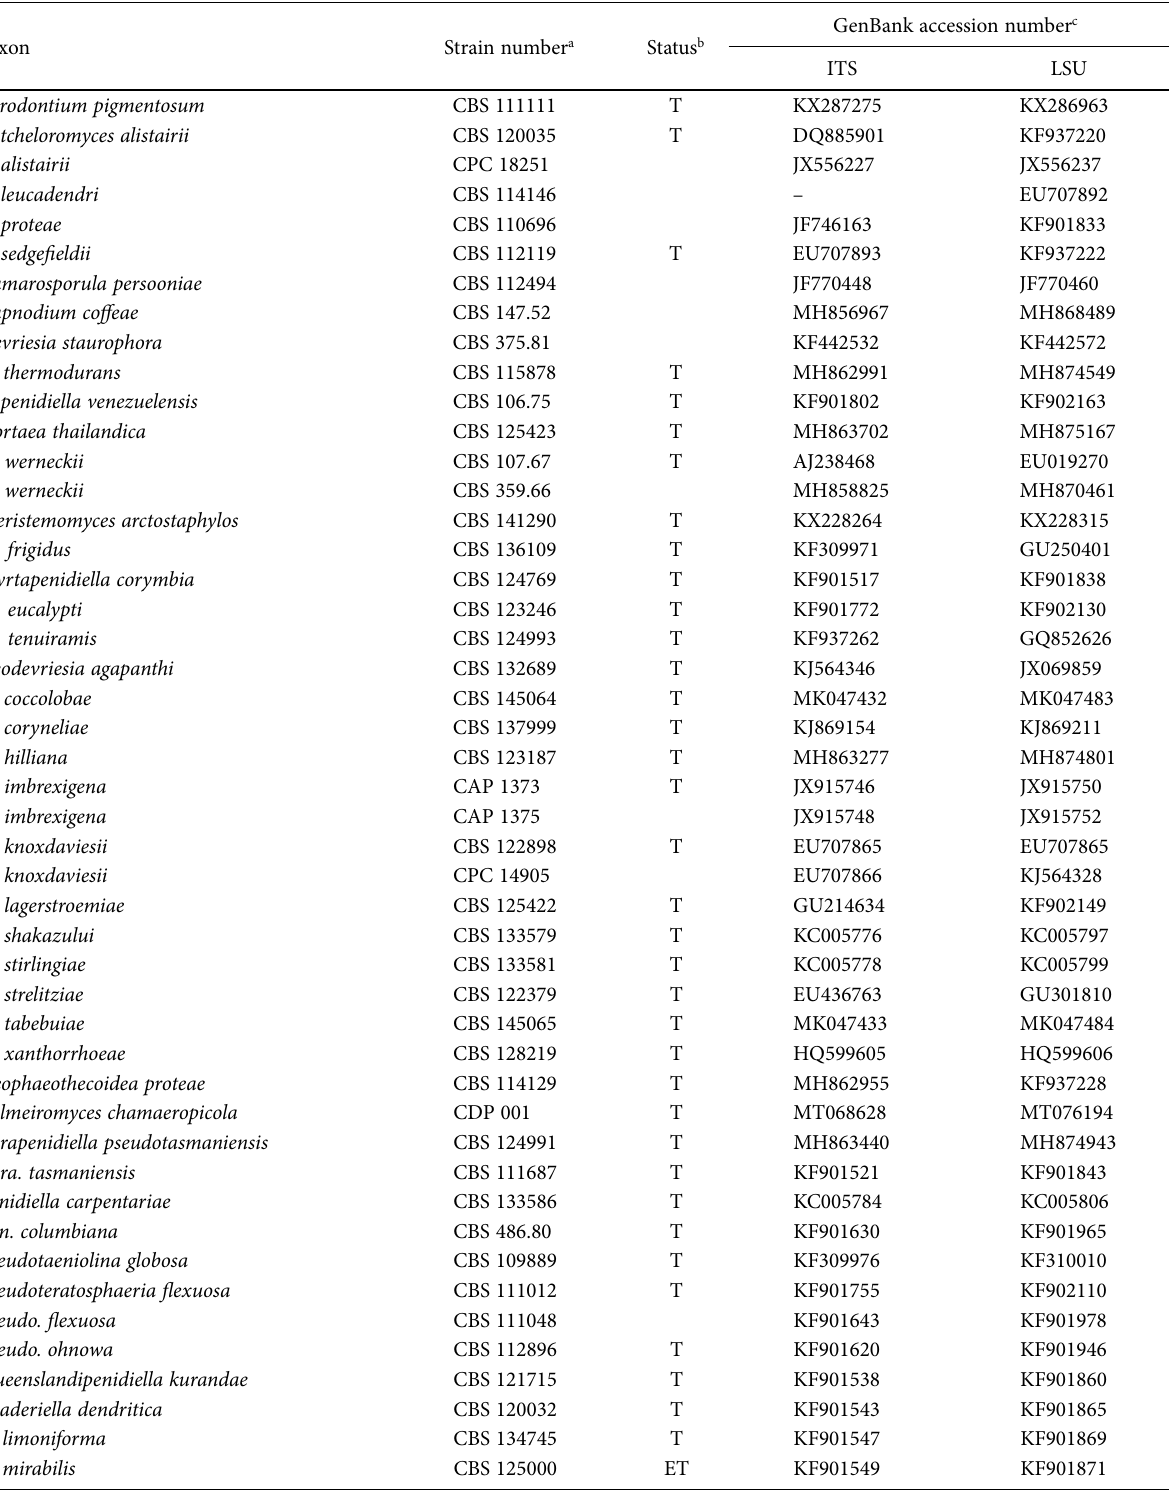
Table 1. Isolates used in the phylogenetic analyses of Palmeiromyces chamaeropicola .